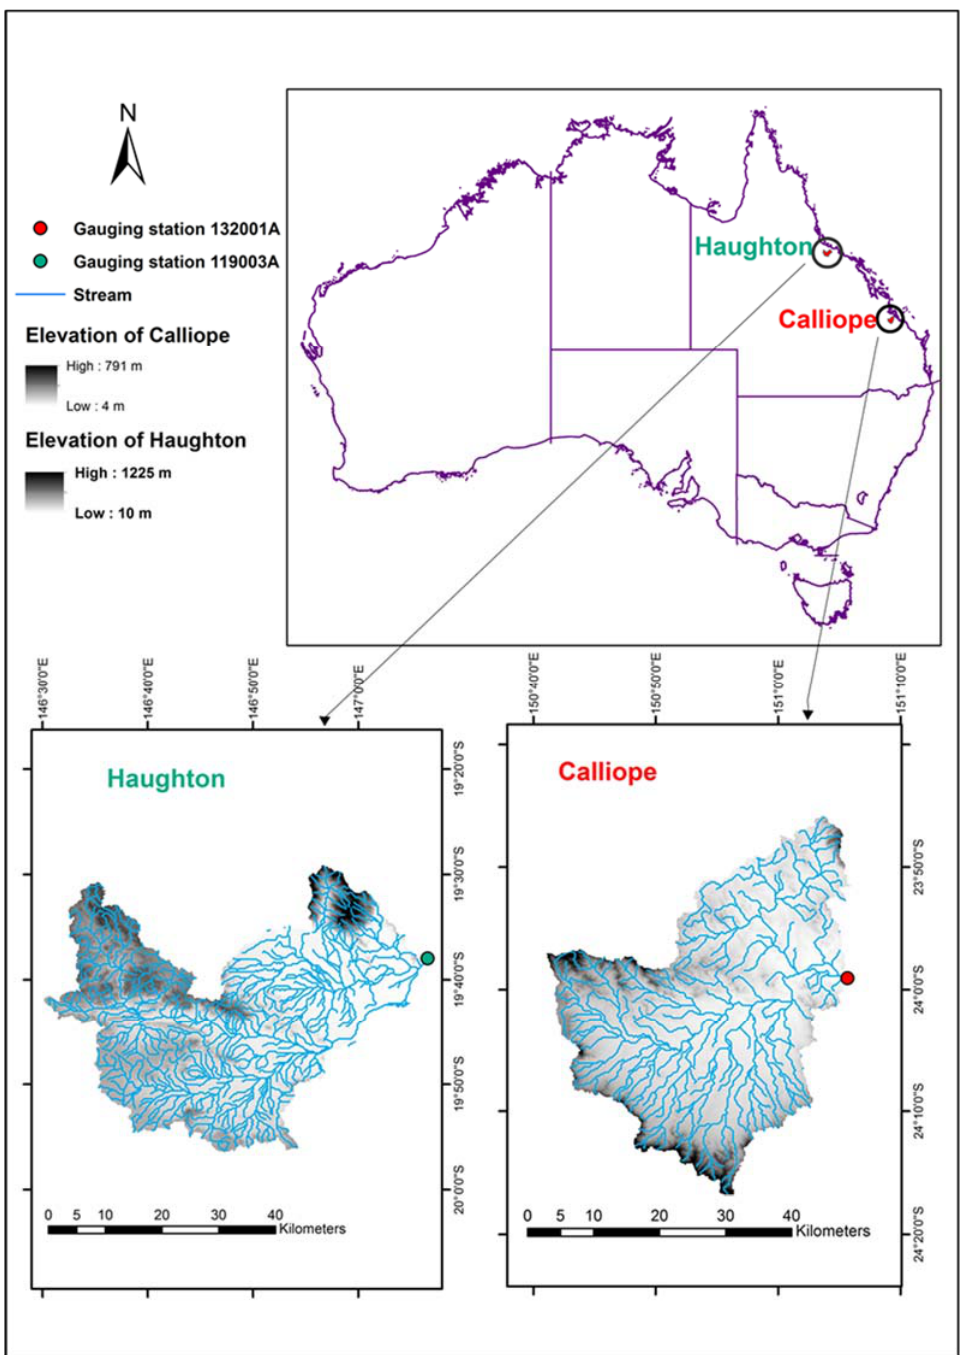
Figure 1. Location of stations and drainage network maps of Haughton and Calliope Rivers. Table 1. Geographical and hydrological characteristics of the studied stations.